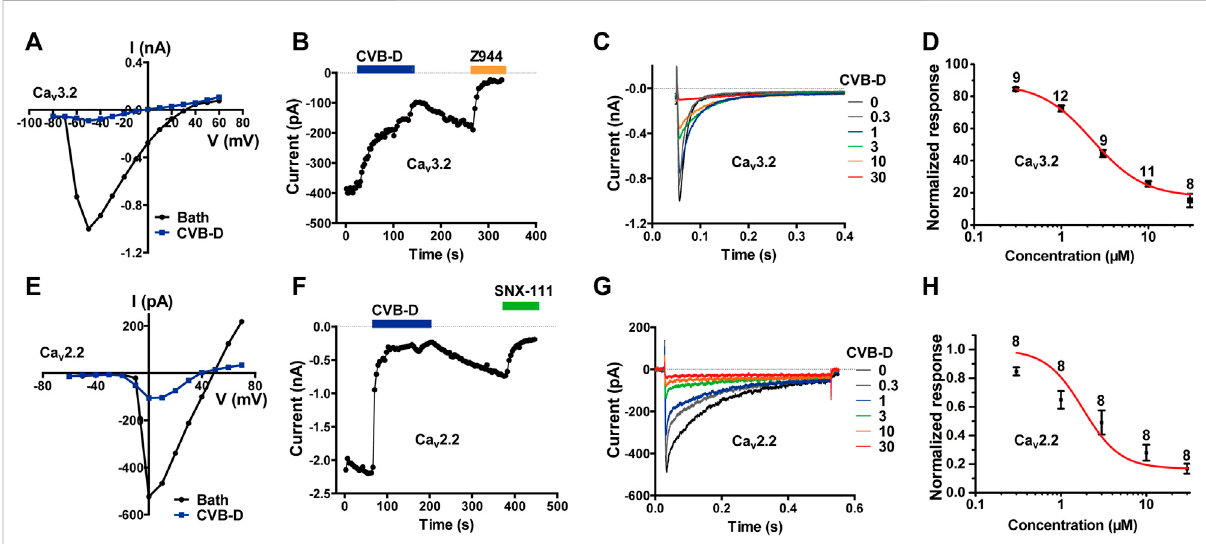
FIGURE 3 CVB-D-mediated inhibition of recombinant Ca v 3.2 and Ca v 2.2 channels expressed in HEK 293T cells. (A) Representative current-voltage (I-V) relationship of Ca v 3.2 in the absence or presence of 30 μ M CVB-D. (B) Time course of inhibition by CVB-D (30 μ M) and subsequent inhibition by Z944 (10 μ M) of Ca v 3.2 peak current. (C) Inhibition of Ca v 3.2 peak current by different concentrations of CVB-D. (D) Dose-response relationship of CVB-D inhibition of Ca v 3.2 peak current. Solid curve represents fi t to the Hill equation. Data are presented as mean ± SEM. n = 8 – 12 for each concentration. (E) Representative I-V relationship of Ca v 2.2 in the absence or presence of 10 μ M CVB-D. (F) Time course of inhibition by CVB-D (10 μ M) and subsequent inhibition by SNX-111 (0.5 μ M) of Ca v 2.2 peak current. (G) Inhibition of Ca v 2.2 peak current by different concentrations of CVB-D. (H) Dose-responserelationshipofCVB-DinhibitionofCa v 2.2peakcurrent.Solidcurverepresents fi ttotheHillequation.Dataarepresented as mean ± SEM. n = 8 for each